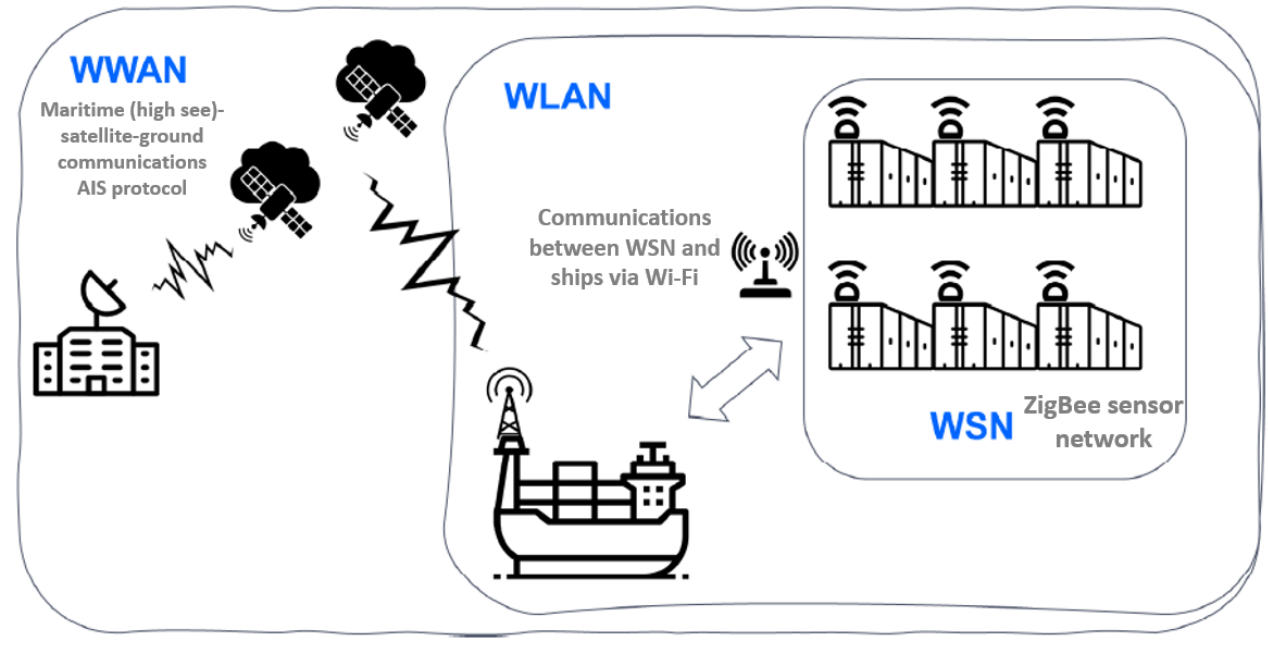
Figure 1. Proposed architecture